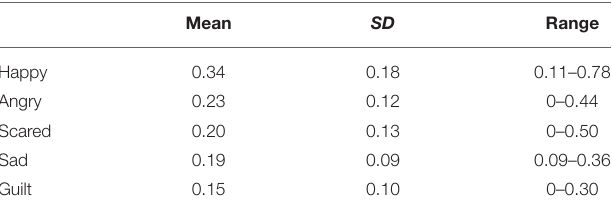
TABLE 3 | Average proportion of emotion words reported in each category in the emotion word checklist on the parent questionnaire.